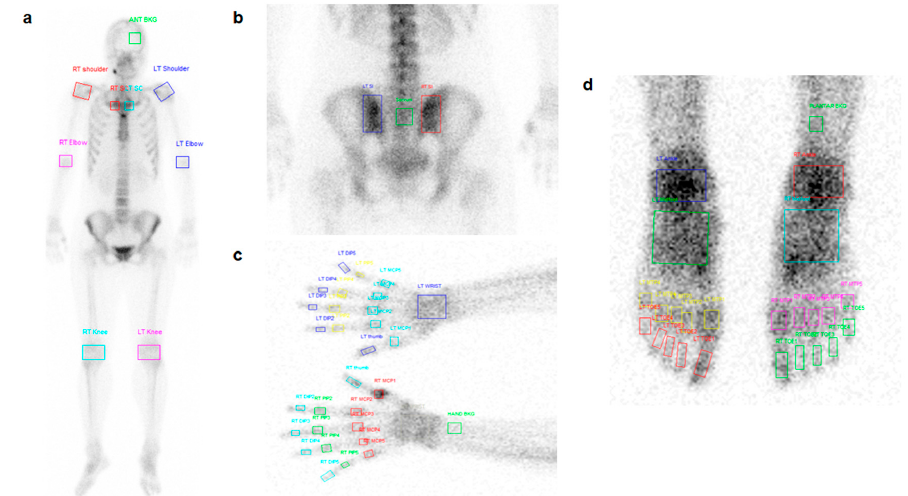
Figure 1. Measurement example of joint uptake ratio in 64 joints of the 14 joint areas (bilateral shoulder, sternoclavicular, elbow, knee, sacroiliac, ankle, tarsal, and wrist joints, 10 metatarso-phalangeal (MTP) joints, 10 interphalangeal (IP) joints of foot, 10 metacarpo-phalangeal (MCP) joints, bilateral thumb IP joints, 8 hand proximal IP (PIP), and 8 hand distal IP (DIP) joints) using an in-house software. We drew a square-shaped region-of-interest for measuring the skull (green), bilateral shoulder (red on right side and blue on left side), sternoclavicular (red on right side and cyan on left side), elbow (pink on right side and blue on left side), and knee joints (cyan on right side and pink on left side) uptake on a whole-body anterior image ( a ), for measuring the sacral bone (green) and bilateral sacroiliac joints (red on right side and blue on left side) uptake on a posterior pelvic spot image ( b ), for measuring the distal radial bone (green), bilateral wrist (blue), MCP (red on right side and cyan on left side), thumb IP (cyan on right side and blue on left side), PIP (green on right side and yellow on left side), and DIP joints (cyan on right side and blue on left side) uptake on a bilateral hands spot image ( c ), and for measuring distal tibial bone (green), bilateral ankle (red on right side and blue on left side), tarsal (cyan on right side and green on left side), MTP (pink on right side and yellow on left side), and toe IP joints (green on right side and red on left side) uptake on a bilateral feet spot image ( d